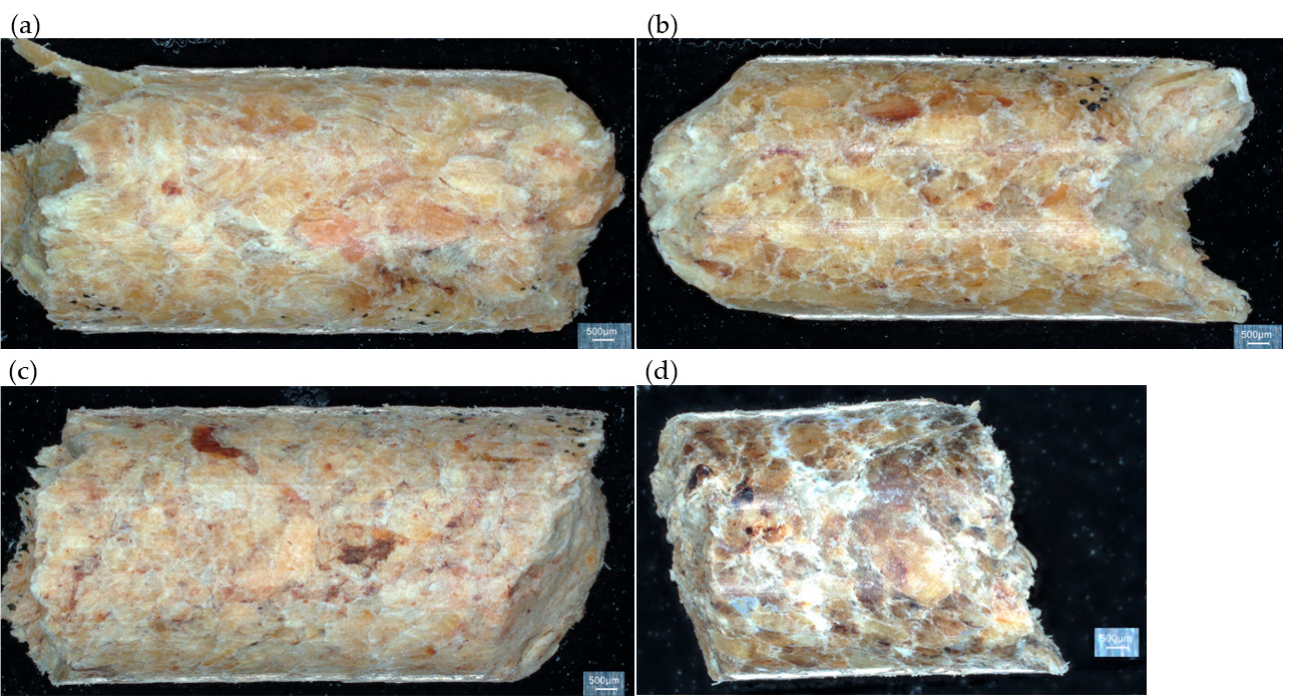
Figure 2. Structure and surface area of tested pellets ( a ) P1, ( b ) P2, ( c ) P3, and ( d ) P4.